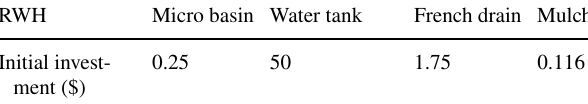
Table 4 The initial recommended investment in